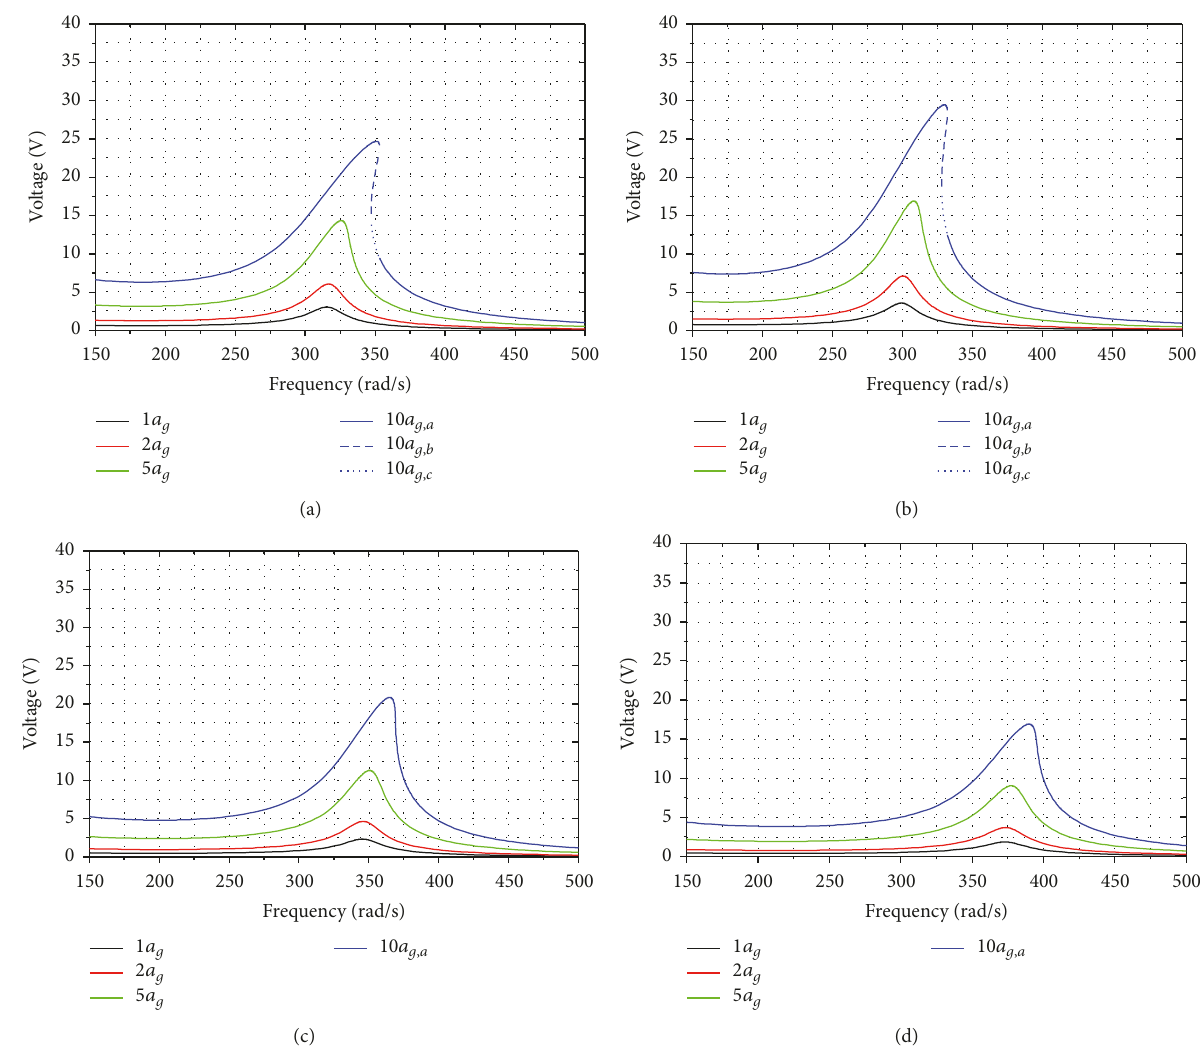
Figure 14: FRFs of the maximum voltage for base acceleration amplitudes ranging from 1 𝑎 𝑔 to 10 𝑎 𝑔 , where (a) 𝑇 PVDF = 𝑇 0 PVDF , (b) 𝑇 PVDF = 0.5𝑇 0 𝑇 = 1.2𝑇 0 𝑇 = 1.4𝑇 0 PVDF PVDF PVDF , (c) PVDF PVDF , and (d)